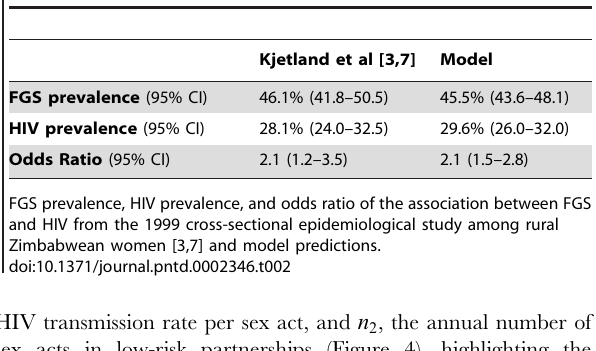
Table 2. Model fit to